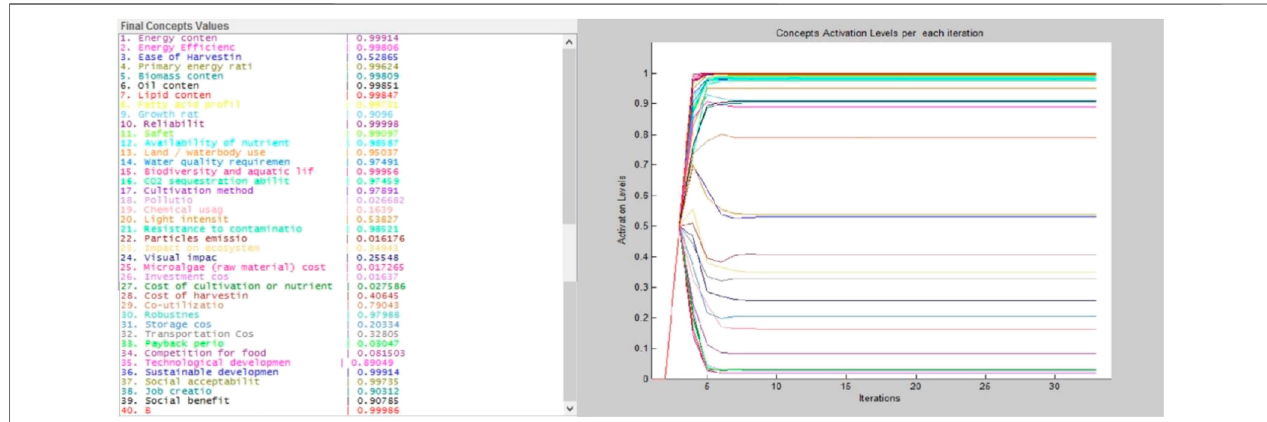
FIGURE 5 | Steady State Analysis for the FCM and convergence curves relatively to the number of iterations.